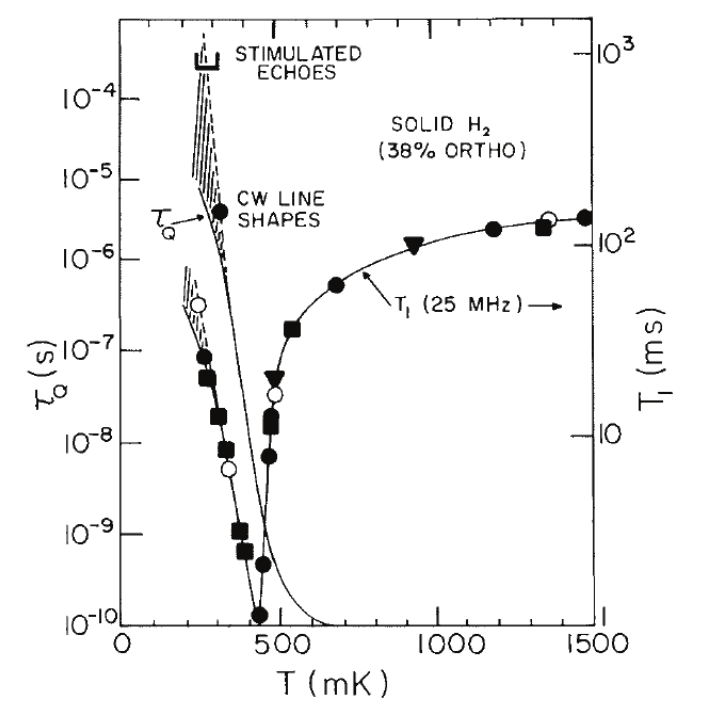
Figure 14. Temperature dependence of the fluctuation rate in quadrupolar glass. Reproduced with permission from Fig. 1 of Ref.[48]. Copyright Elsevier,